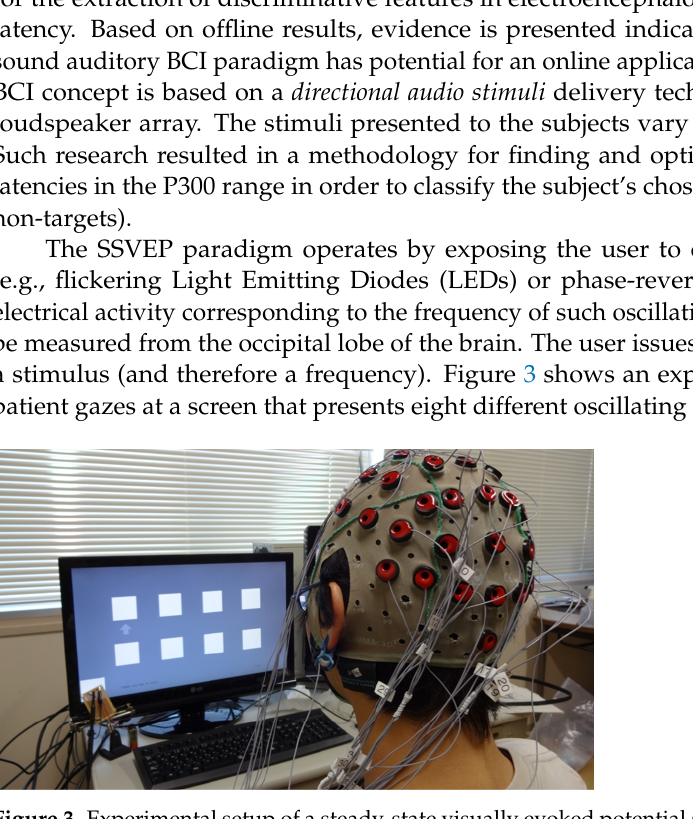
Figure 3. Experimental setup of a steady-state visually evoked potential (SSVEP) recording: A patient gazes at a screen that presents eight different patterns corresponding to eight different intended commands to the interface. Each pattern oscillates with a different frequency: whenever the patient gazes at a particular pattern, neuronal oscillations take place in the visual cortex, which locks up with the frequency of the flickering pattern (from the Department of Electrical and Electronic Engineering at the Tokyo University of Agriculture and